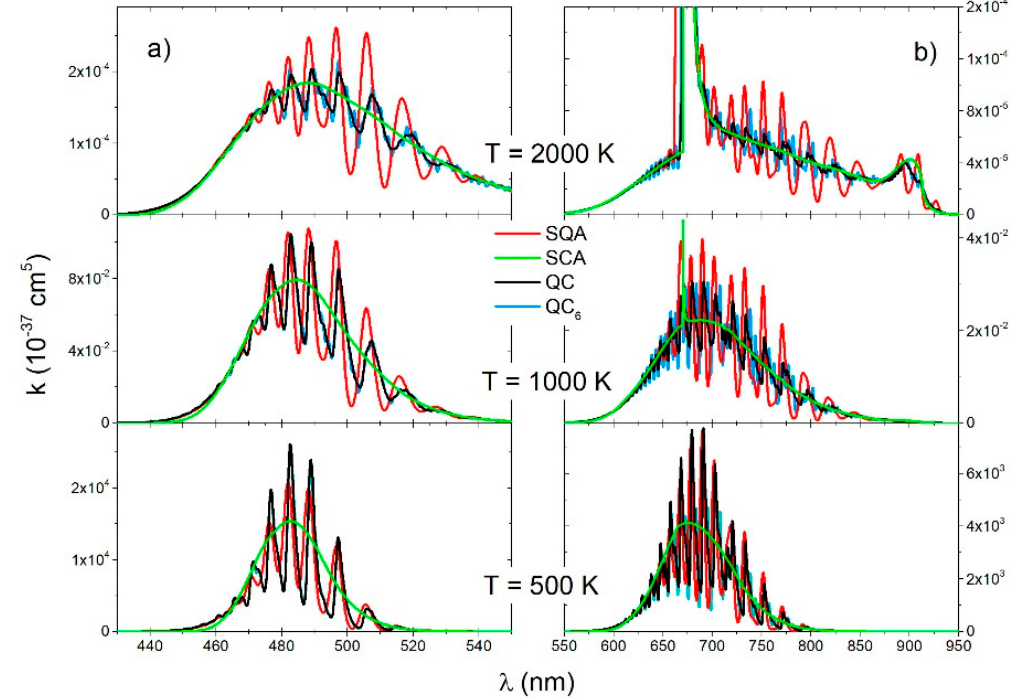
Figure 5. Li 2 molecule, reduced absorption coefficient for the B 1 Π u → X 1 Σ + g ( a ) and A 1 Σ + u → X 1 Σ + g transitions ( b ) for three different temperatures (2000 K, 1000 K, 500 K), obtained with four theoretical approaches (SQA, QC 6 , QC,